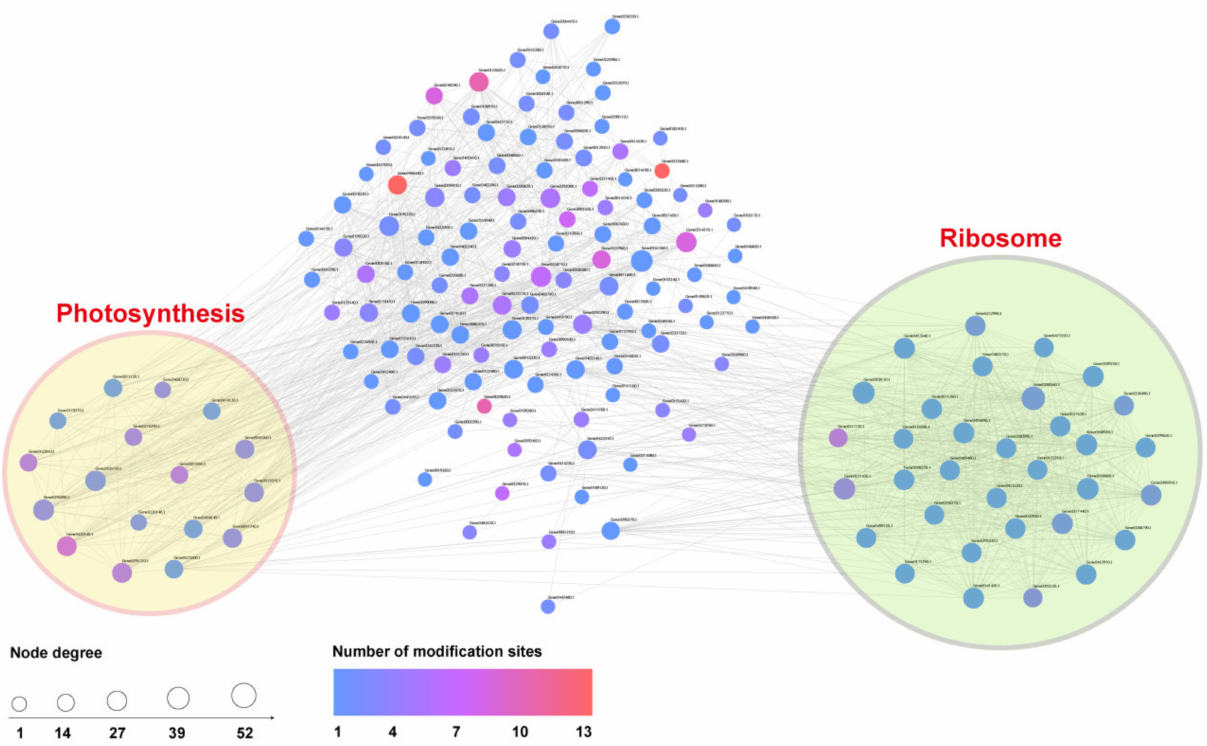
Figure 4. Protein interaction networks of succinylated proteins identified in the shoots of turnip seedlings. The circle size represents the node degree, and the color represents the succinylation site number on the